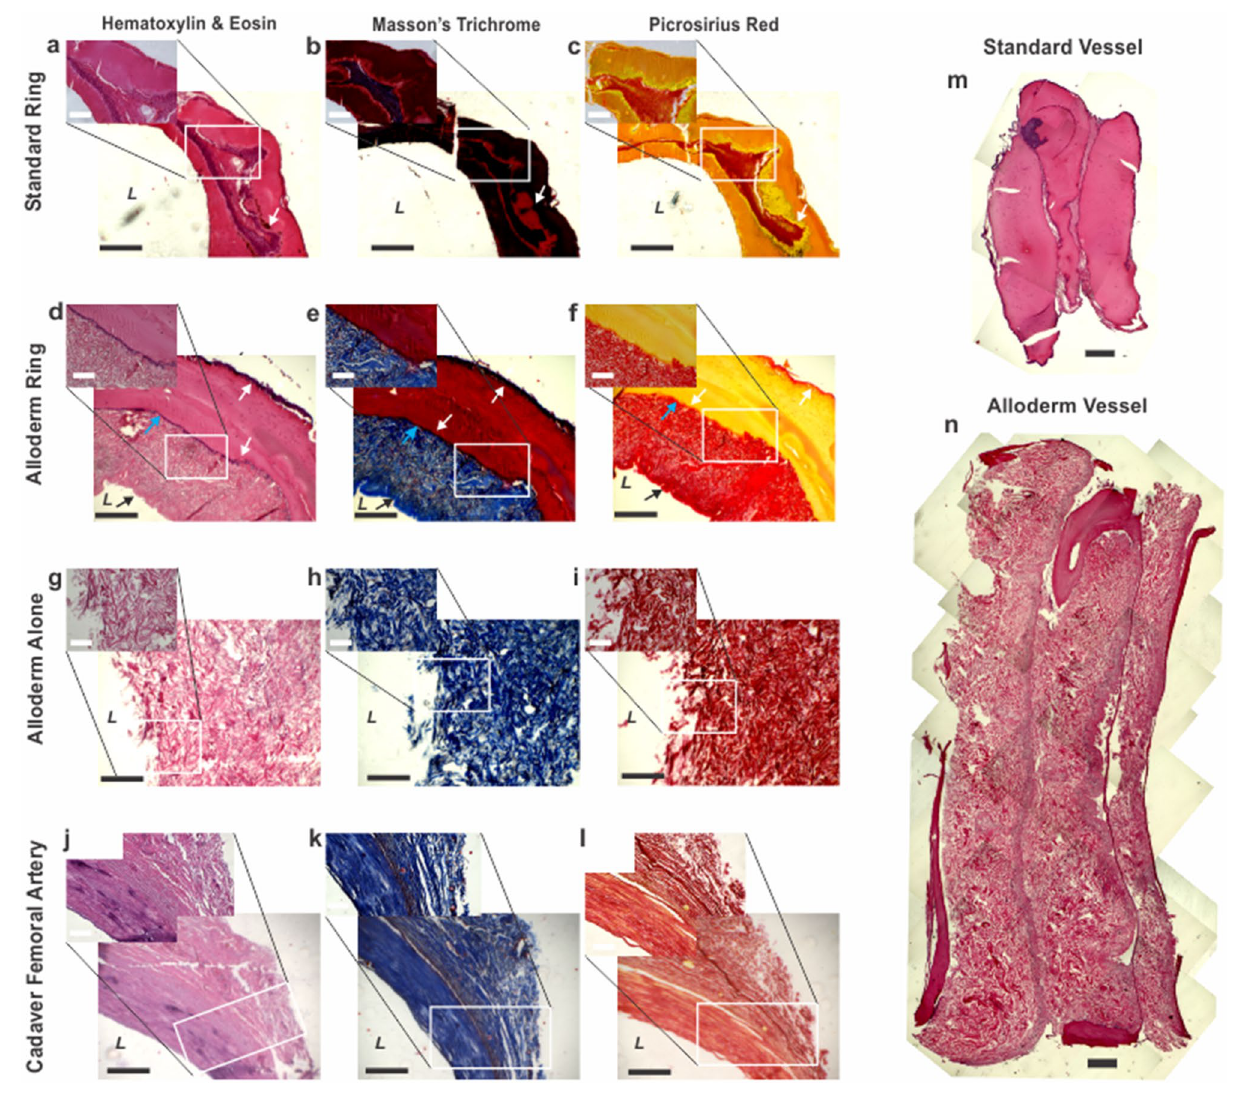
Figure 4. Extracellular matrix and cellular organization in engineered vascular rings and vessels improved with inclusion of Alloderm. H&E, trichrome and picrosirius red stains of ( a–c ) standard rings, ( d–f ) Alloderm rings, ( g–i ) Alloderm alone, and ( j–l ) cadaver femoral artery. Standard rings show well organized cells (white arrows) surrounded by fibrin gel ( a–c ). The addition of Alloderm (black arrows) further improved tissue organization by providing structural support for the cells (white arrows) and fibrin gel (blue arrows) around which to organize ( d–f ). Alloderm’s dense, organized collagen is evident in the stains of Alloderm alone ( g–i ). The Alloderm rings were the most similar in morphology and cellular organization to the cadaver femoral artery ( j–l ). H&E stained longitudinal sections of engineered vessels ( m,n ) show the ring-to-ring integration within the vessels, and the improvement of tissue organization with inclusion of Alloderm ( n ) compared to standard vessels without Alloderm ( m ). L indicates lumen side. White scale bars = 200 µm; black scale bars = 500